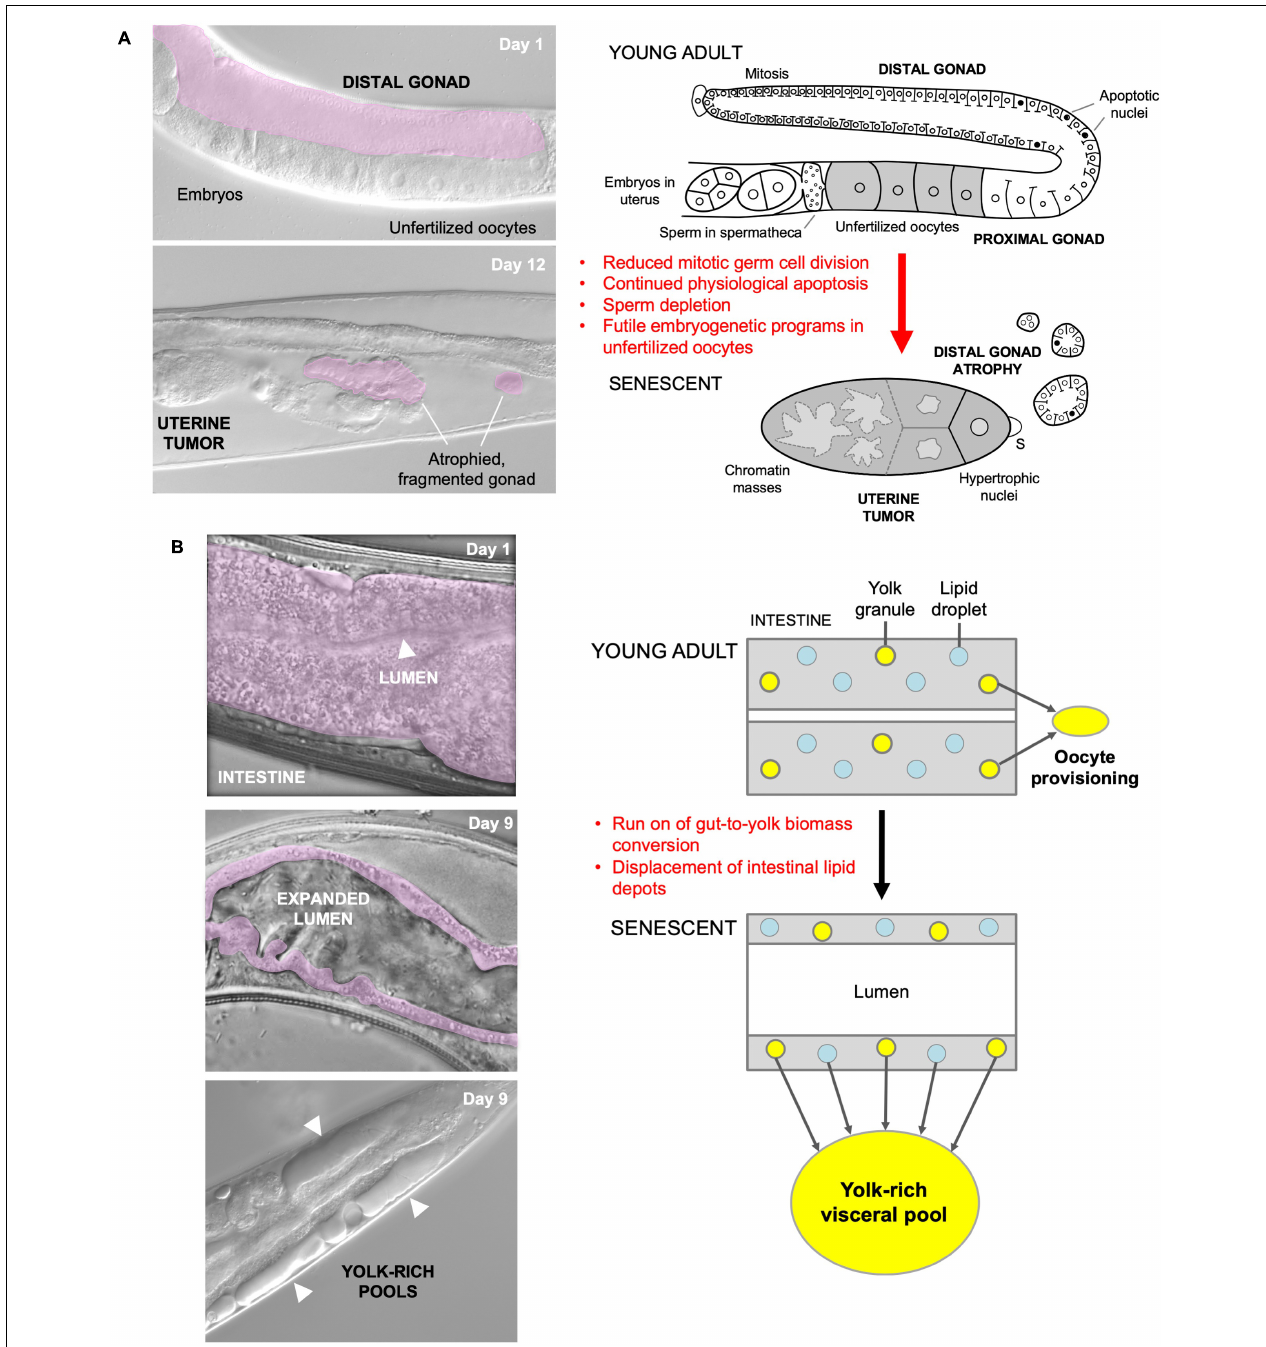
FIGURE 1 | Quasi-programs as a cause of C. elegans hermaphrodite senescence. (A) Distal gonad atrophy and teratoma-like uterine tumor formation. Left: appearance of pathologies under Nomarski microscopy; distal gonad marked in pink. Right: proposed pathophysiology involving quasi-programs. In the young adult oocytes are generated by proliferation of mitotic germline stem cells which then enter meiosis, and then in most cases undergo physiological apoptosis (PA) to generate cytoplasm to fill expanding oocytes (Gumienny et al., 1999; Jaramillo-Lambert et al., 2007; Wolke et al., 2007). Subsequently, declining stem cell division (conceivably adaptive) (Kocsisova et al., 2019) and run-on of PA promotes distal gonad atrophy and fragmentation (de la Guardia et al., 2016). Unfertilized oocytes fail to complete meiosis, enter the uterus and develop into teratoma-like tumors containing massively polyploid chromatin masses (Golden et al., 2007) which appears to result, as in mammalian ovarian teratomas, from embryonic quasi-programs (Wang et al., 2018a,b). (B) Left, intestinal atrophy and yolk-rich visceral pool accumulation. Right, hypothesis for etiology of both pathologies: a vitellogenic quasi-program, where remobilization of intestinal biomass into yolk continues in a futile fashion (Ezcurra et al., 2018; Benedetto and Gems,